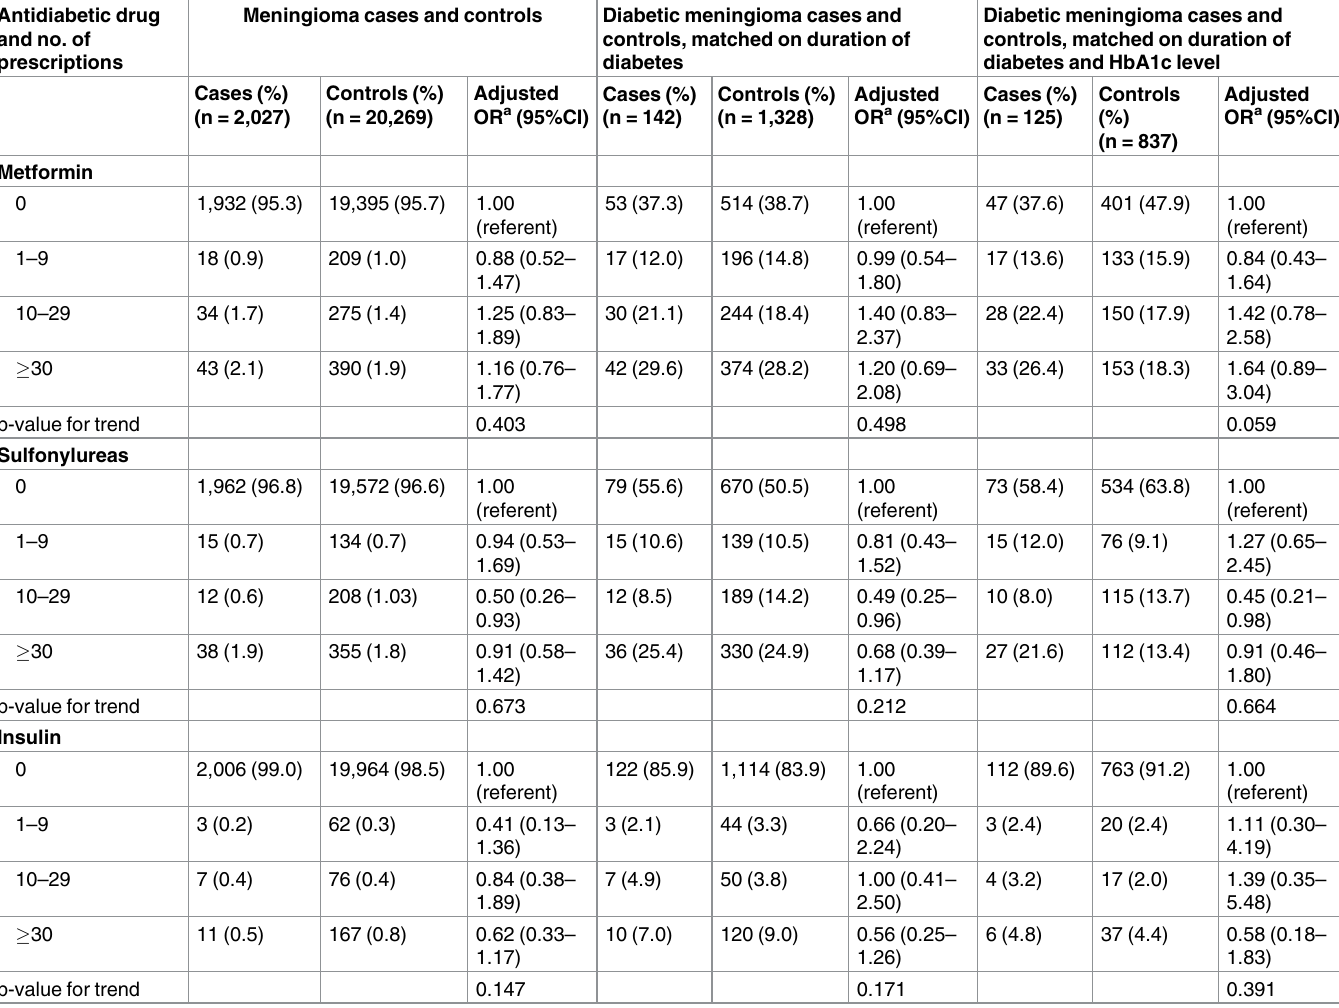
Table 3. Risk of meningioma in relation to number of prescriptions for anti-diabetic drugs. Antidiabetic drug and no.